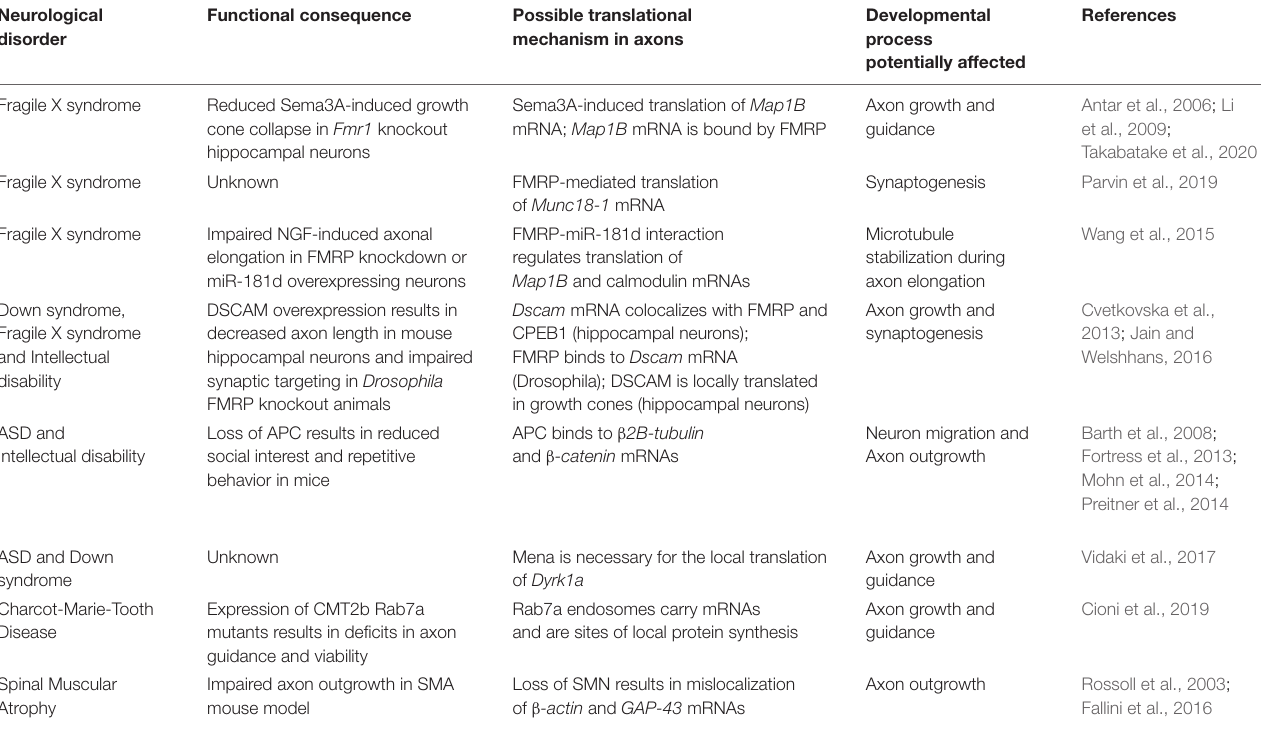
TABLE 1 | Altered local translation in neurological